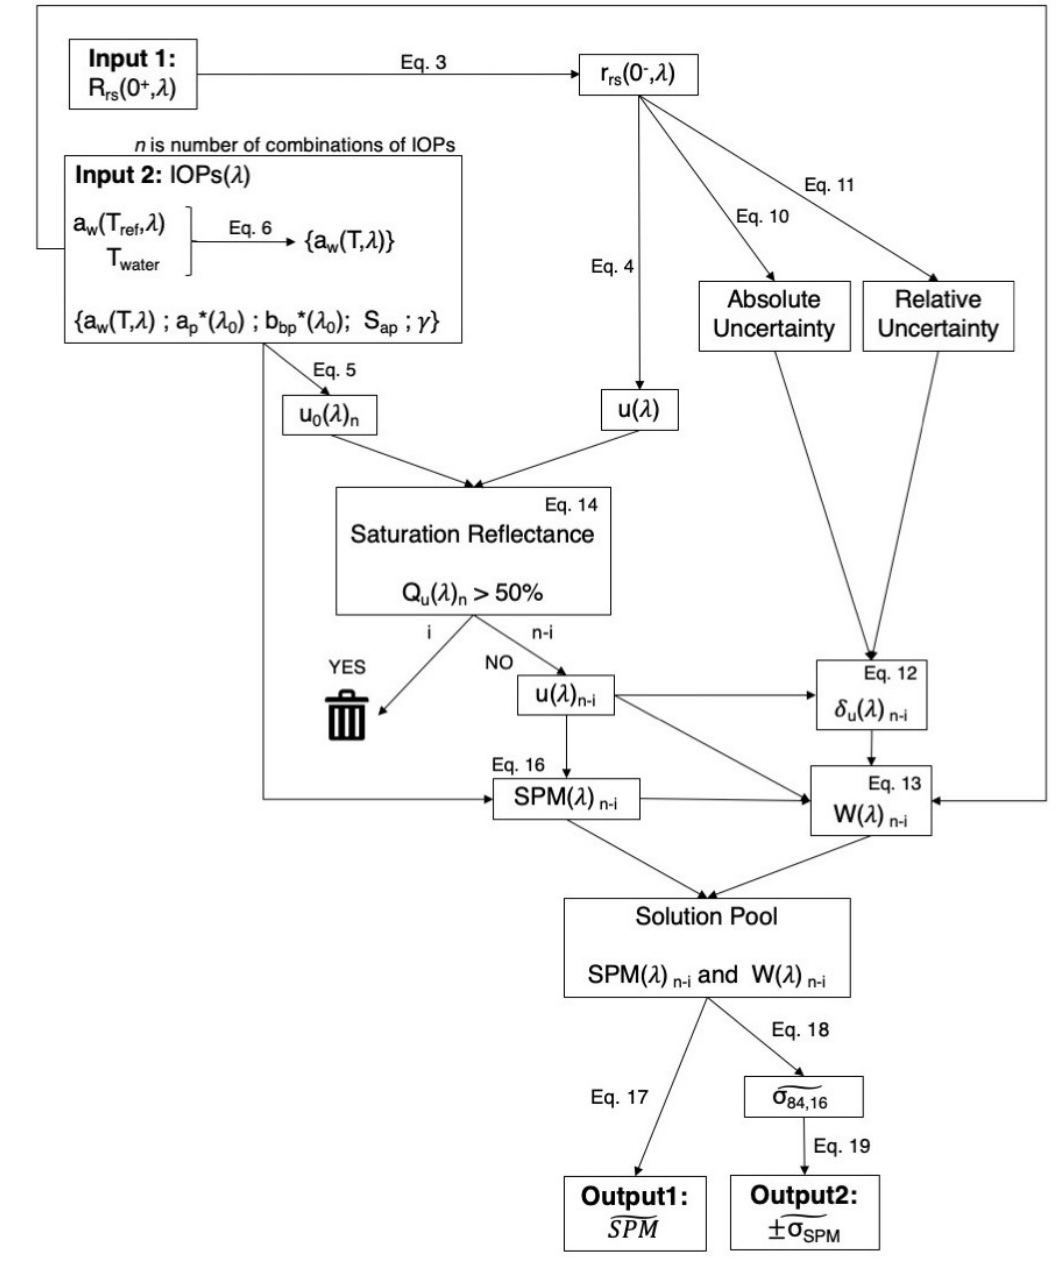
Figure 2. A schematic of the MW algorithm is provided in Figure 2 (see Table 3 for symbols, definitions, and units). See also the MW algorithm Supplementary Material available as a package of Matlab functions. (MW algorithm Matlab script is available at: https://github.com/OceanOptics/MW_